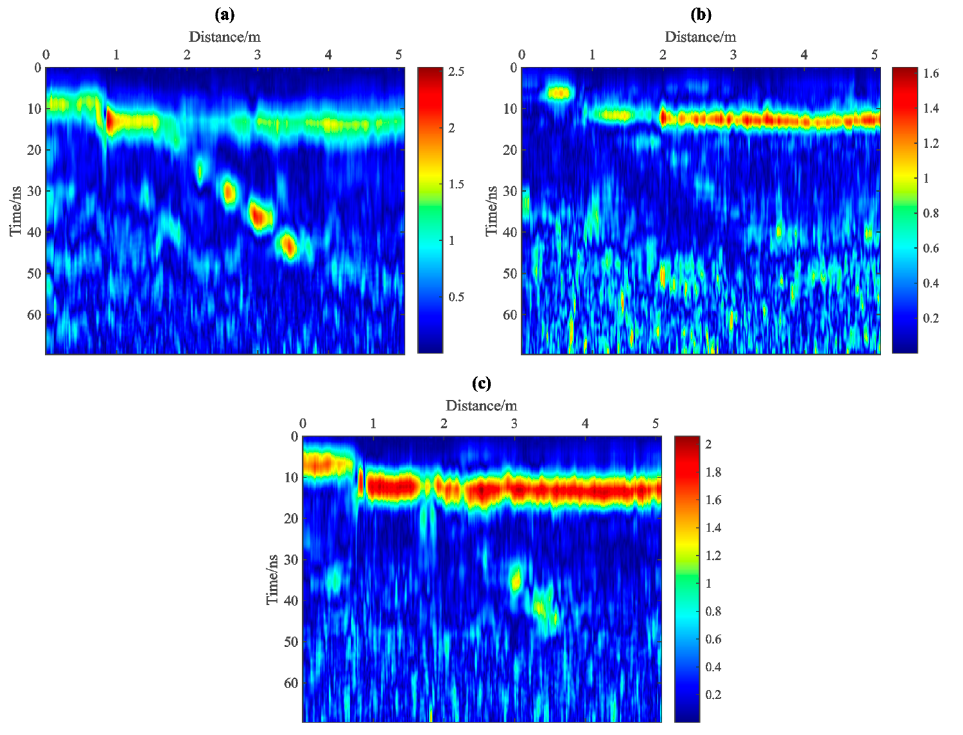
Figure 15. The instantaneous amplitude profiles of IMF-slices 1 − 3 ( a − c ) for the field data by using MVMD, respectively.